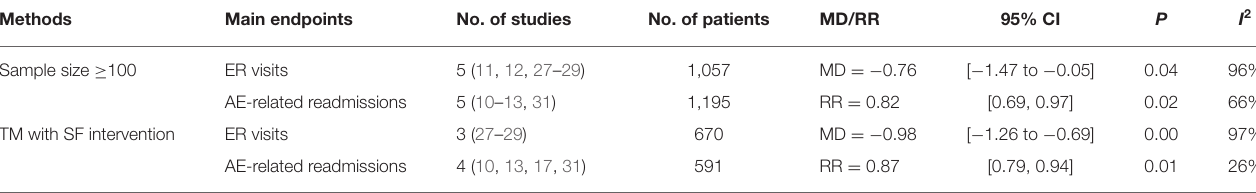
TABLE 2 | Sensitivity analyses specific to sample size ≥ 100 or intervention of TM with